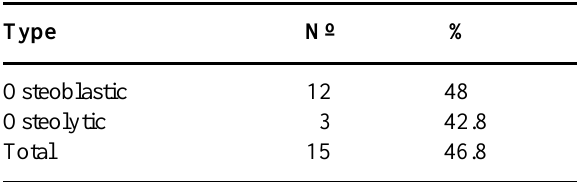
Table 2 - Improvement in radiological image after treat- ment with bisphosphonate.